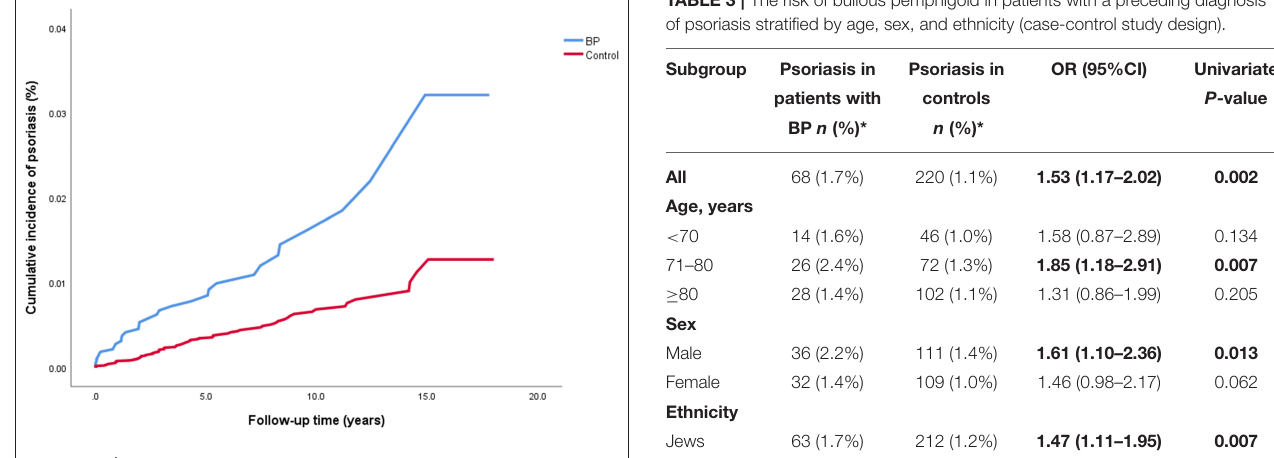
FIGURE 1 | The cumulative incidence of psoriasis among patients with BP.